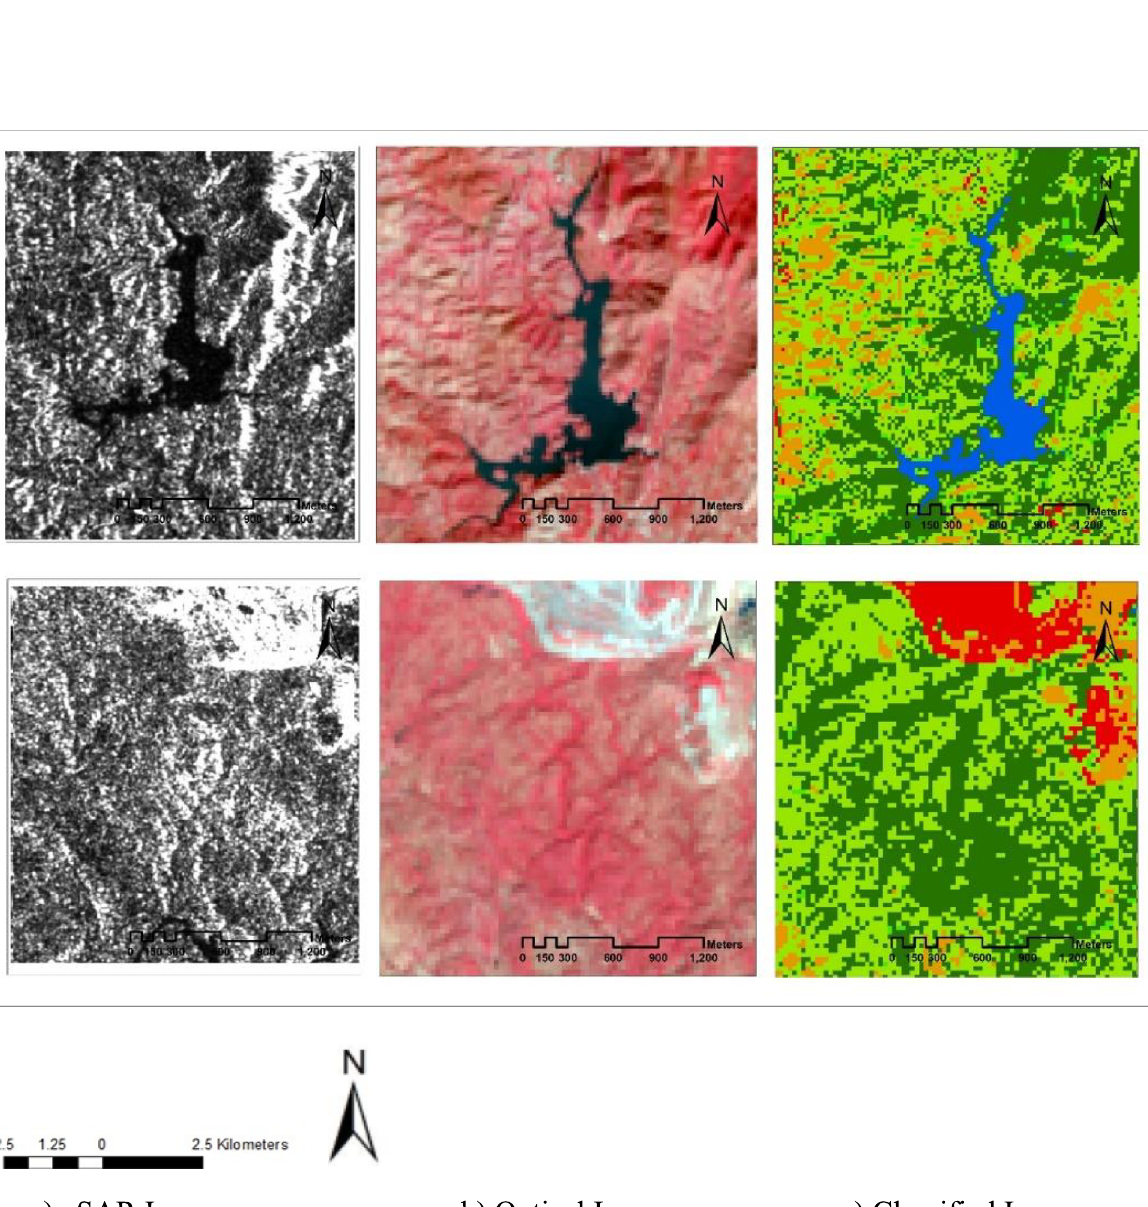
Fig. 13 Selected Green and Blue